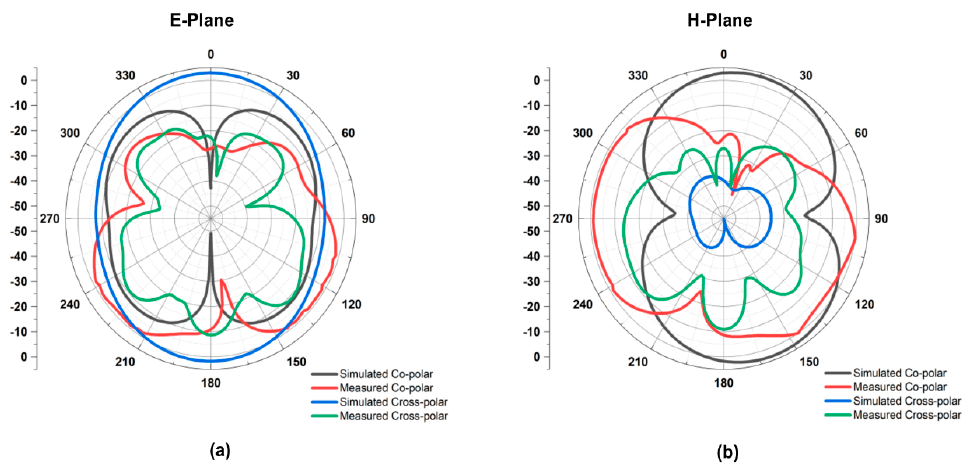
Figure 7. Simulated and measured radiation pattern of the proposed flexible antenna in 7.75 GHz in ( a ) E-Plane and ( b ) H-plane.